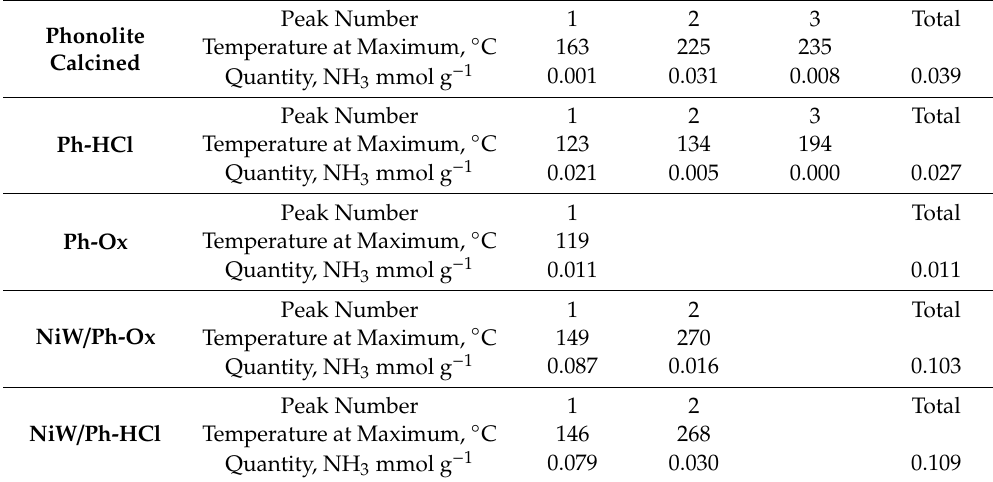
Figure 3. Ammonia temperature programmed desorption (NH 3 -TPD) profiles of phonolite modified supports and the maxima of the TPD signals with each particular percentage contribution. Table 3. Ammonia temperature programmed desorption (NH 3 -TPD) peak signals and temperatures at each maximum. The total ammonia desorbed at each deconvoluted peak is indicated as “Total”.